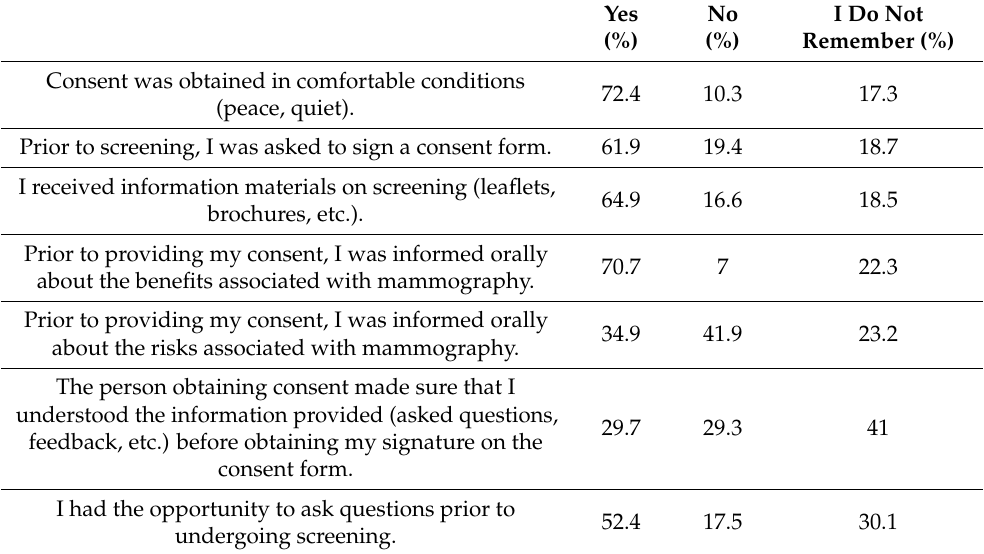
Table 1. Formal criteria of consent.